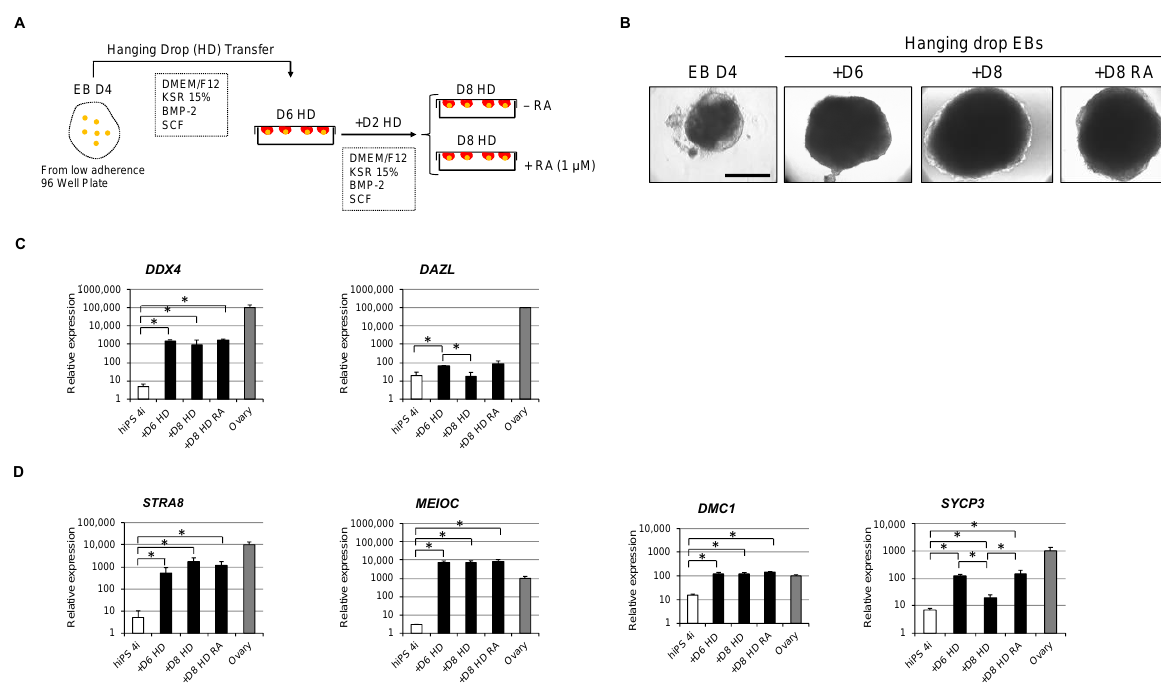
Figure 6. In vitro overexpression of late hPGC-LC and meiotic gene markers in hanging drop-transferred embryoid bodies. ( A ) Schematic illustration of in vitro culture procedure of day 4 embryoid bodies